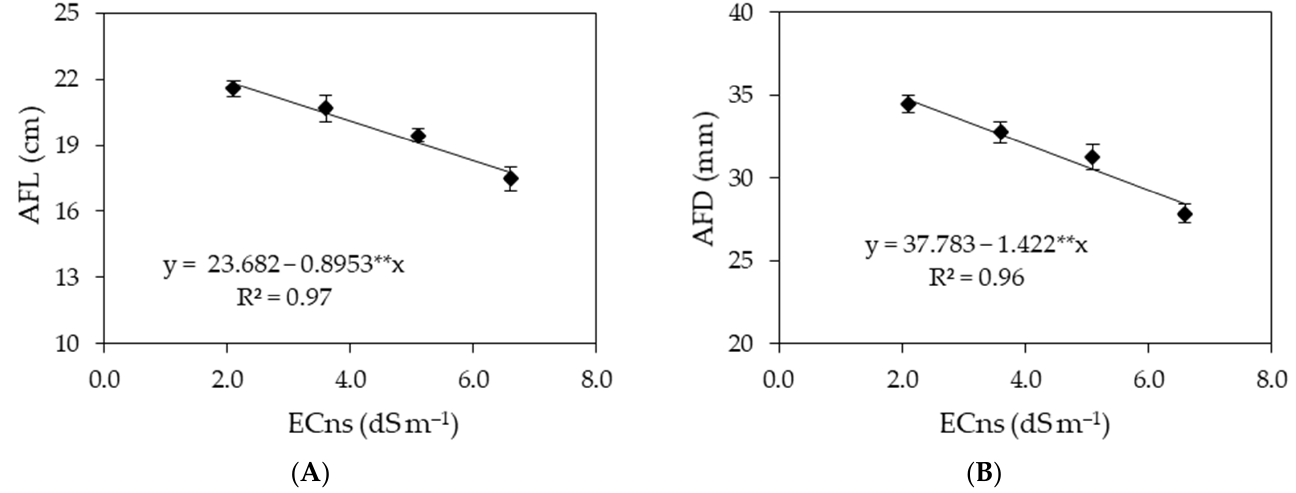
Figure 10. Average fruit length—AFL ( A ) and average fruit diameter—AFD ( B ) of Japanese cucumber cultivated in a hydroponic system as a function of the electrical conductivity of the nutrient solution (ECns), 45 days after transplanting. ** significant at a p ≤ 0.01. Vertical lines represent the standard error of the mean ( n = 4). Table 6. Summary of the analysis of variance (ANOVA) for hydrogen potential (pH), soluble solids (SS), ascorbic acid (AA), and titratable acidity (TA) of fruits of Japanese cucumber grown in a hydroponic system with saline nutrient solution and foliar application of salicylic acid, 45 days after transplanting.